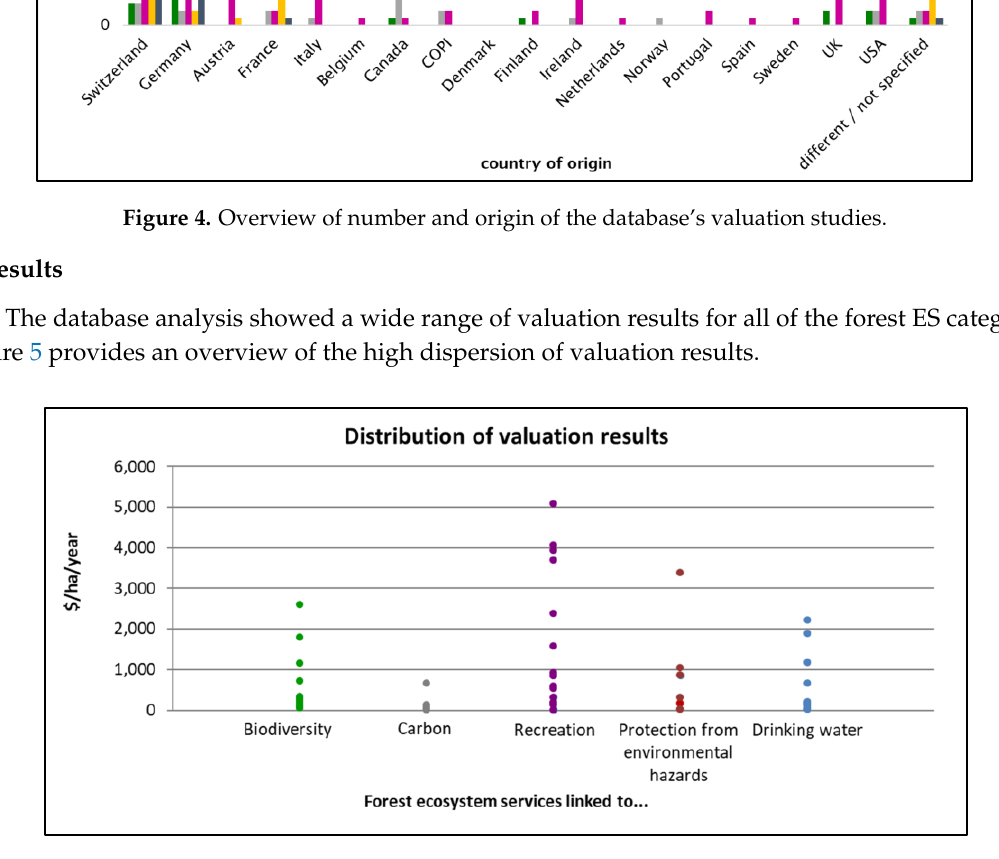
Figure 4. Overview of number and origin of the database's valuation studies.